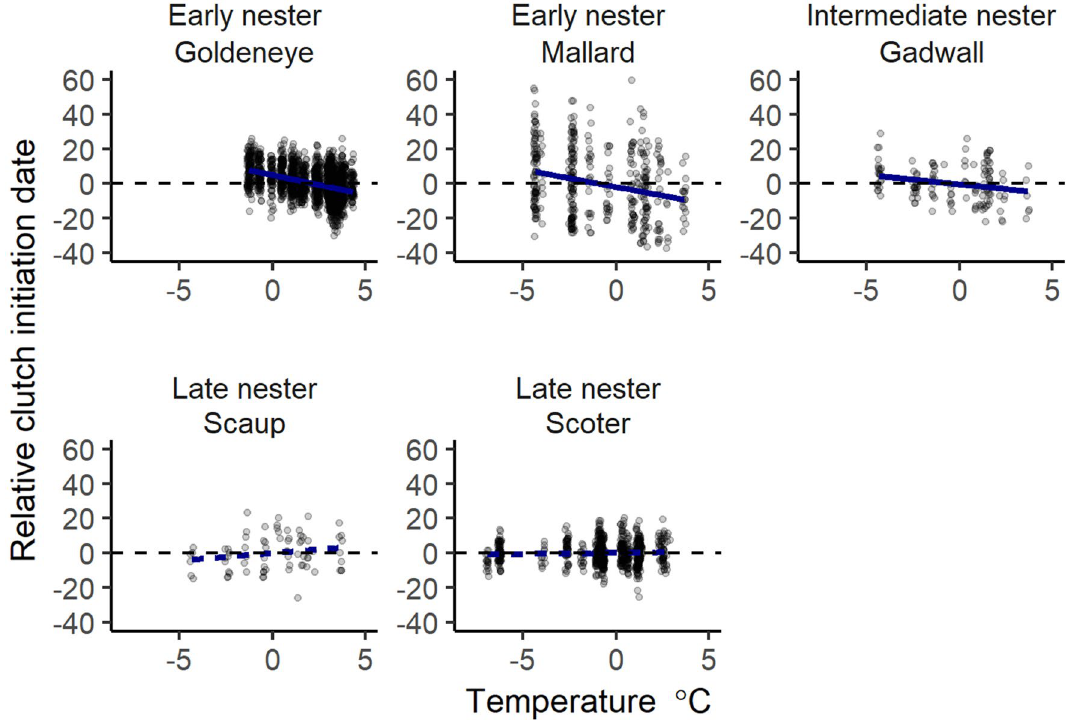
Figure 2. Population-level response to spring temperature by species. A regression line is included for illustrative purposes from the linear model ‘clutch initiation date ~ spring temperature’. Slope of response from full model is reported in Fig. 3, dashed lines indicate 95% confidence intervals overlapped 0.